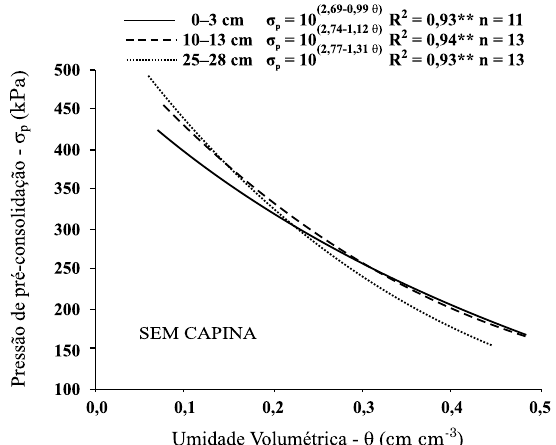
Figura 1. Modelos da capacidade de suporte de car- ga do Latossolo Vermelho-Amarelo das profun- didades de 0–3, 10–13 e 25–28 cm.